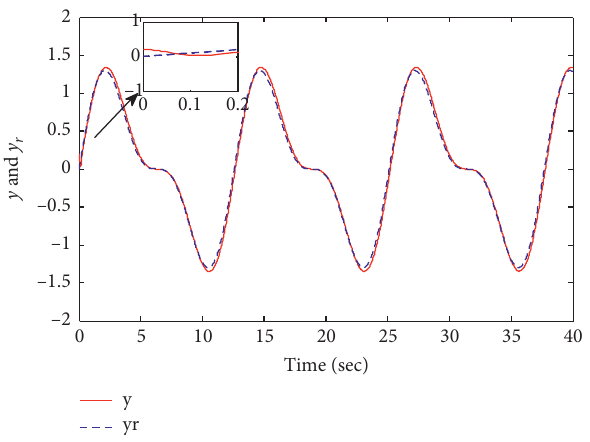
Figure 7: Output y and desired trajectory y